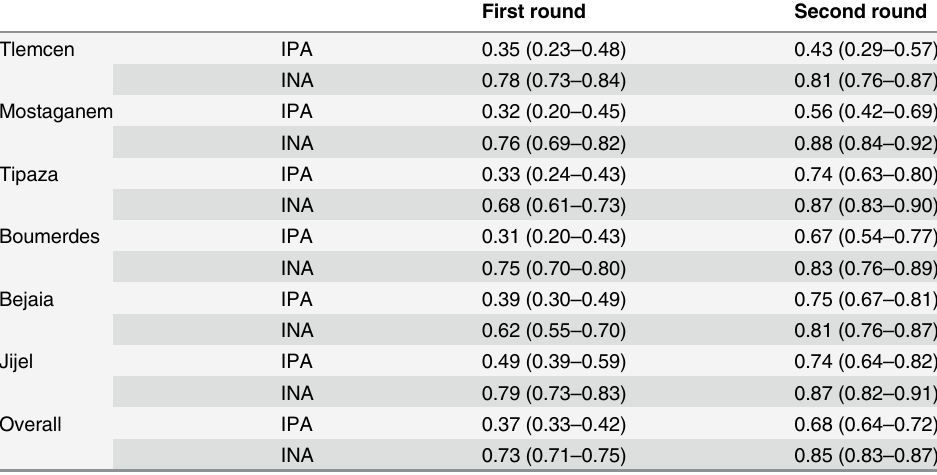
Table 4. Concordance between IFAT and DAT: indices of positive agreement (IPA) and negative agree- ment (INA) and 95% confidence intervals.